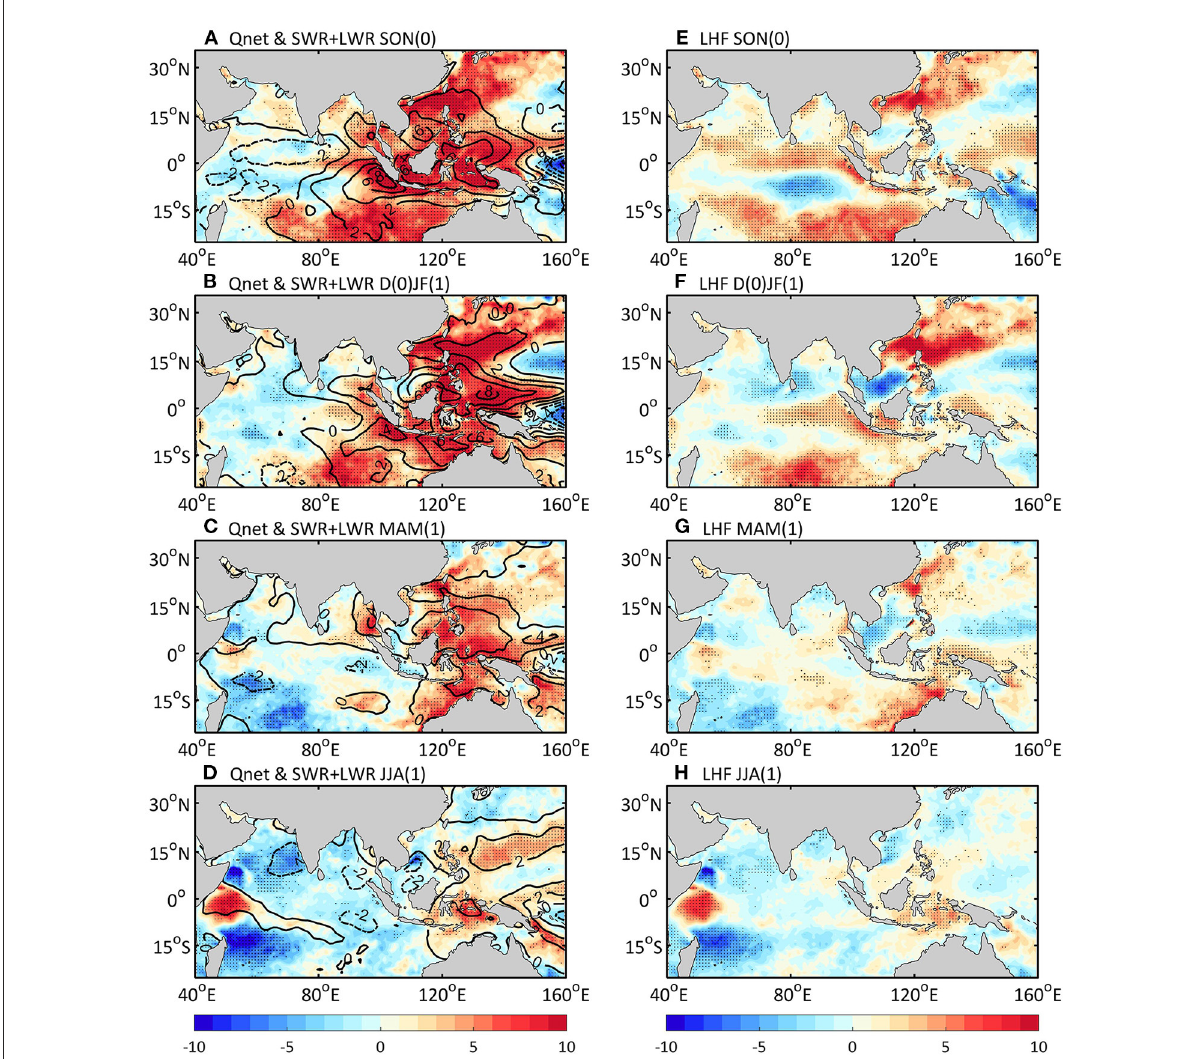
FIGURE6 Anomalies of ERA5 monthly Qnet (sum of latent heat flux, sensible heat flux, shortwave radiation and longwave radiation, shading, W m − 2 ) and shortwave plus longwave radiation (contour, W m − 2 ) (A–D) , and monthly latent heat flux (shading, W m − 2 ) (E–H) regressed onto NDJ Niño 3.4 SST from 1982-2021. Positive means heat into the ocean. Stippling indicates a confidence level > 95% for Qnet and latent heat flux based on students’ t -test. Linear trends and seasonal cycles are